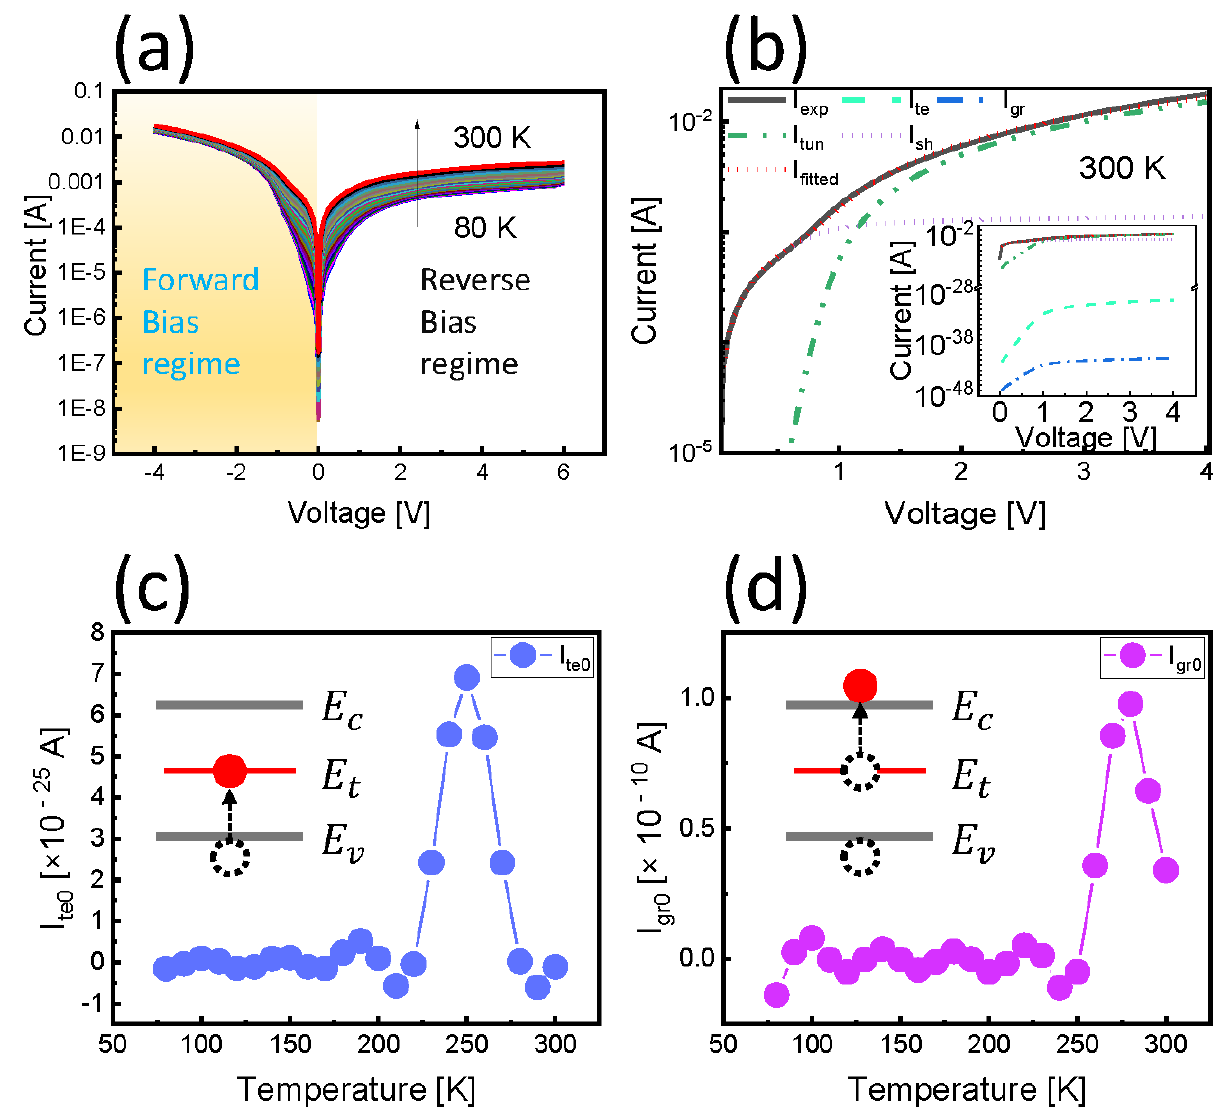
Figure 4. ( a ) I–V–T plot of the Schottky diode from 80 to 300 K. ( b ) I–V fitting with various transport mechanisms. ( c ) The temperature of the maximum peak of the temperature-dependent thermionic emission coefficient also coincides well with that of the DLTS signal found. ( d ) Note that after 250 K, deep traps act as generation–recombination centers. Inset in ( c , d ) indicates the generation process when Temperature elevates.